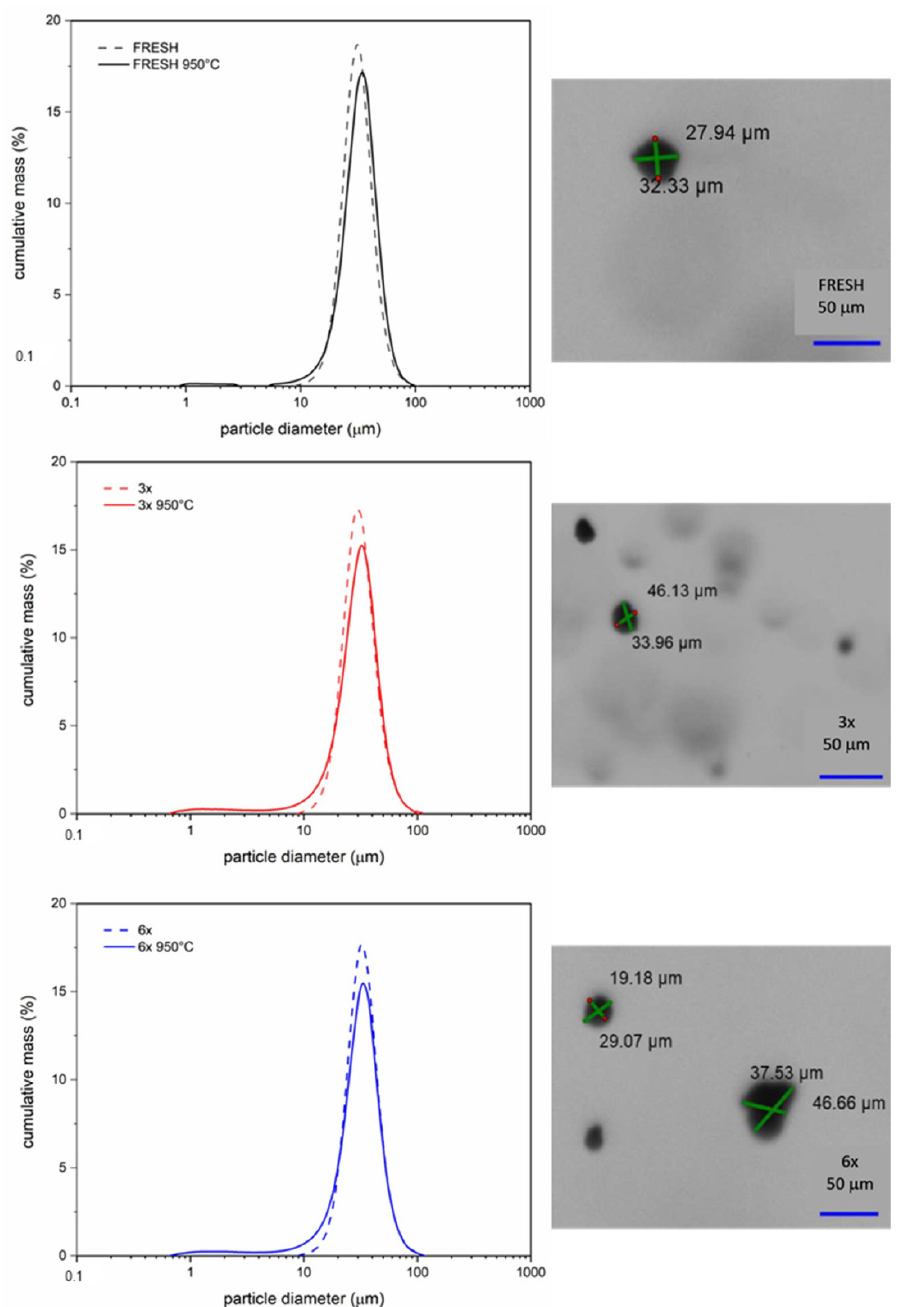
Figure 6. Particle size distributions (lognormal distributions) of the FRESH, 3× and 6× used samples and temperature treatment of the FRESH 950 °C, 3× 950 °C and 6× 950 °C samples. The optical im- ages of FRESH, 3× and 6× samples.